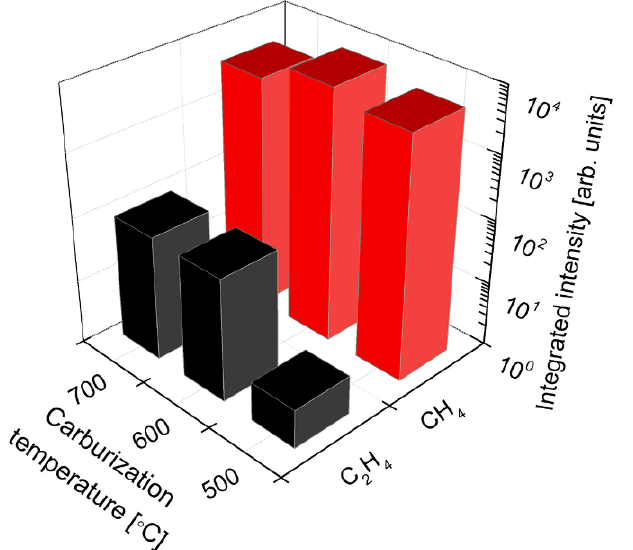
Figure 4. Comparison of the integrated intensities I